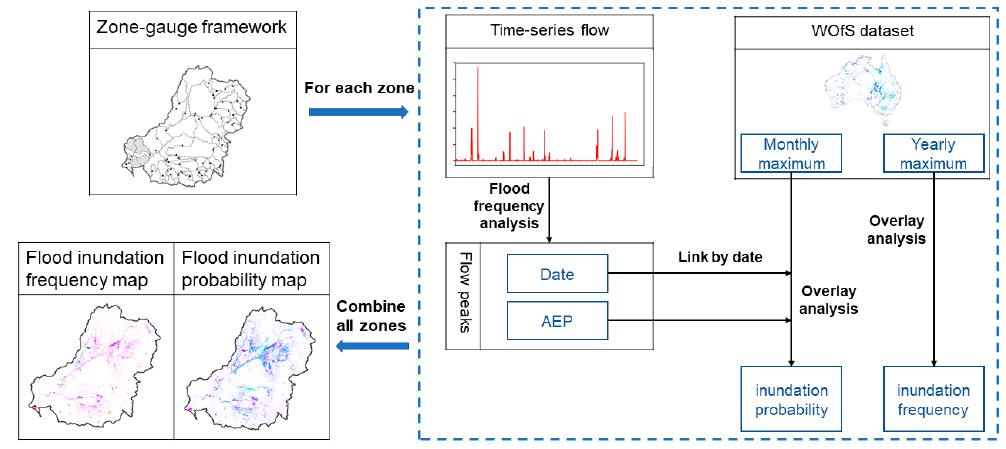
Figure 3. Flowchart of the modeling process.